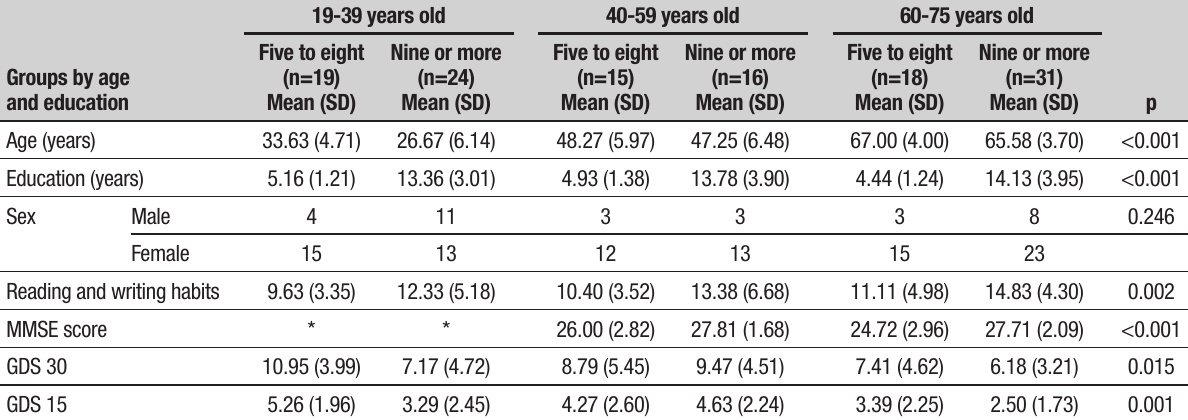
Table 1. Sociodemographic, cultural and clinical characteristics of preliminary normative groups for Modified Wisconsin Card Sorting Test.